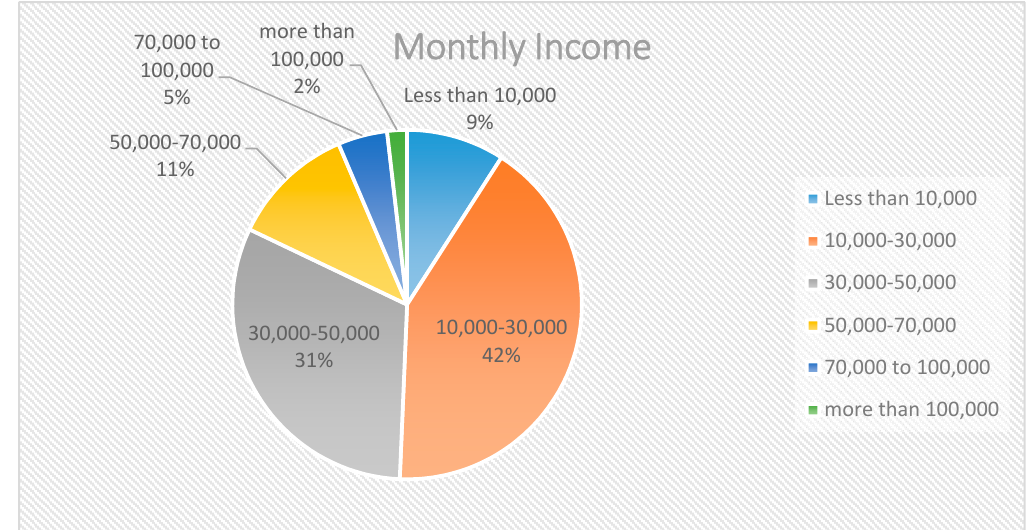
Figure A2. Households’ monthly income in Faisalabad in 2015.